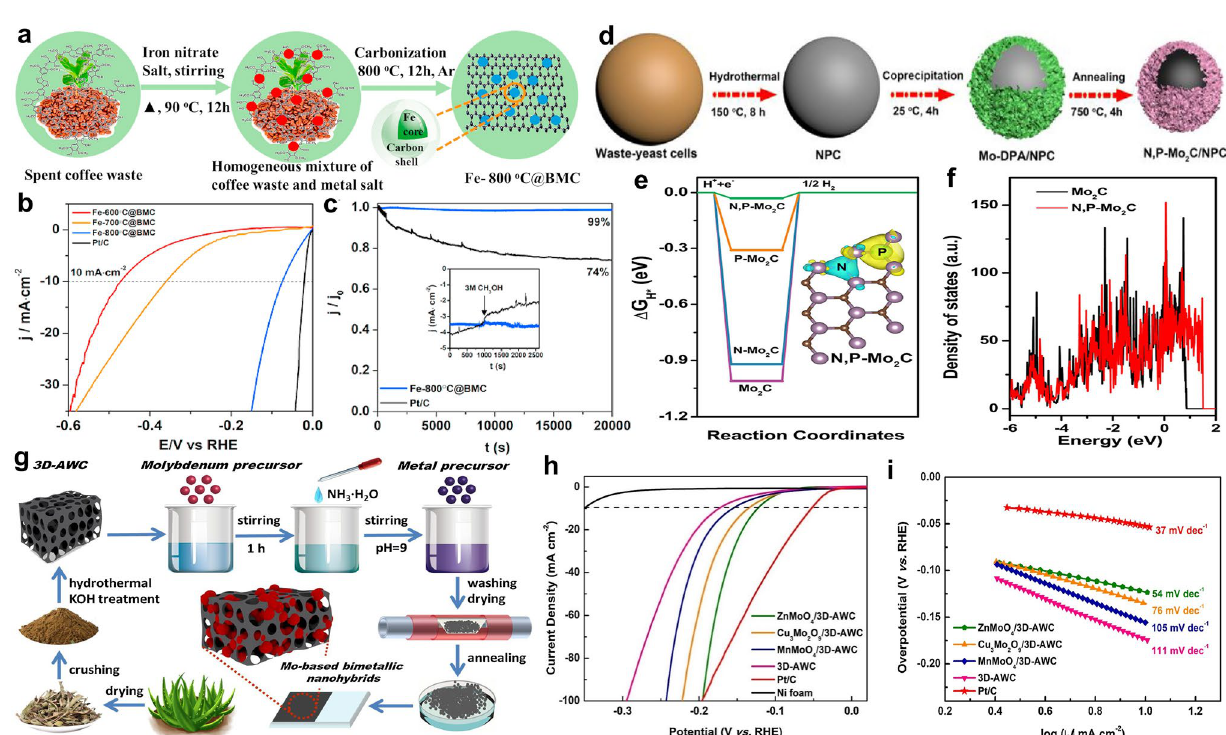
Fig. 7 a Diagram of the preparation of Fe‑800 °C@BMC catalyst. b LSV curves catalysts in 0.5 M H 2 SO 4 . c Chronoamperometric curves of Fe‑800 °C@BMC and Pt/C catalysts at the overpotential of 350 mV, the inset shows the crossover effect of Fe‑800 °C@BMC and Pt/C catalyst with the addition of 3 M methanol [122]. Copyright 2020, Elsevier. d Illustration of the reutilization of waste‑yeast cells to design N, P‑Mo 2 C/ NPC catalyst. e Computational hydrogen adsorption free energy (ΔG H* ) at the equilibrium potential, and the inset shows Bader charges of the N, P‑Mo 2 C catalyst. f Calculated DOS for Mo 2 C and N,P‑Mo 2 C catalysts [126]. Copyright 2022, Elsevier. g Scheme of the synthesis of Mo‑based bimetallic oxides and their carbon‑based hybrids. h LSV curves and i Tafel plots of catalysts in 1.0 M KOH [129]. Copyright 2020,